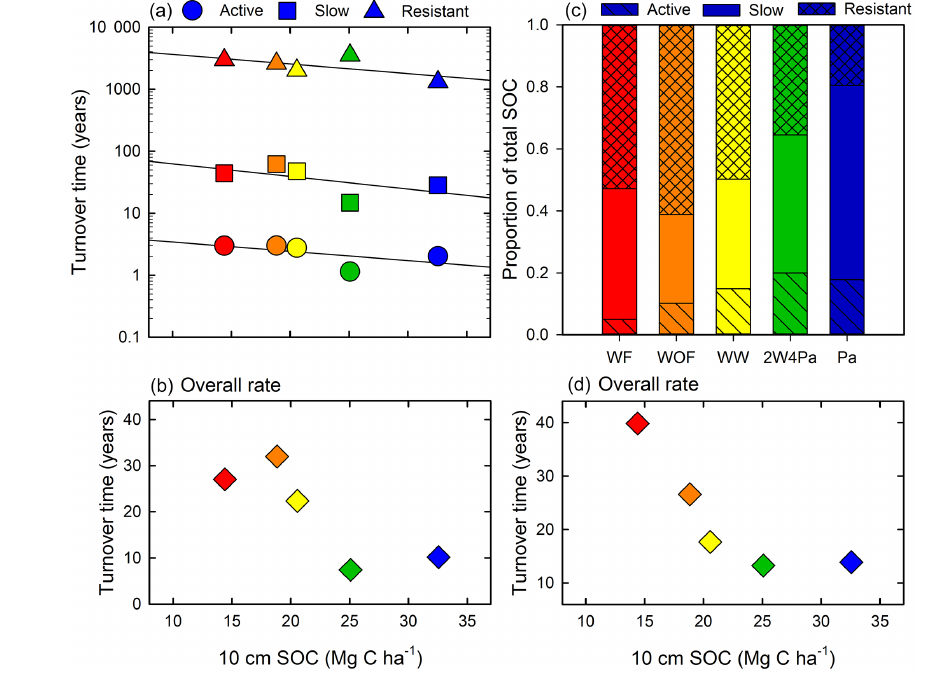
Figure 4. Turnover time for soil organic carbon (SOC) pools (a) and inventory-weighted SOC turnover time (b) for best-fit model solutions when allocation of C to fractions from MIR-PLSR predictions was used (scenario 1). In (c) , best-fit model solutions for allocation of SOC to pools when turnover times were fixed at 3, 50 and 1000 years for active, slow and resistant pools, respectively (scenario 2), with the inventory-weighted overall turnover time given in (d) . Colors representing the five treatment sites as in Fig. 1. Table 5. Short-term microbiological activity assays (mean of sampling times ± 1SD reported). One-way repeated-measures ANOVA sum- mary given below each data column and pairwise comparisons between rotations are indicated with different letters in each column when significant ( α< 0 .